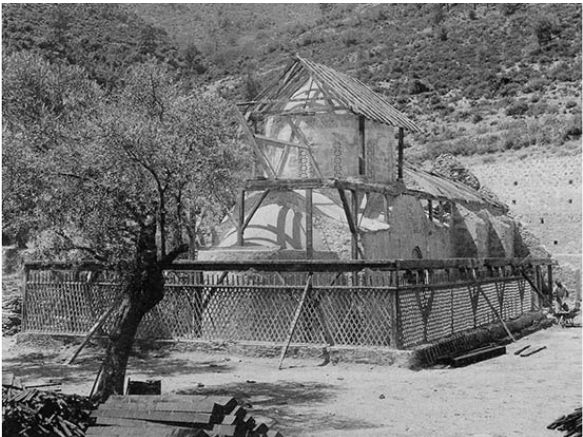
Figure 7. Panagia tou Araka, Lagoudhera, 1957, exterior, Department of Antiquities of Cyprus.